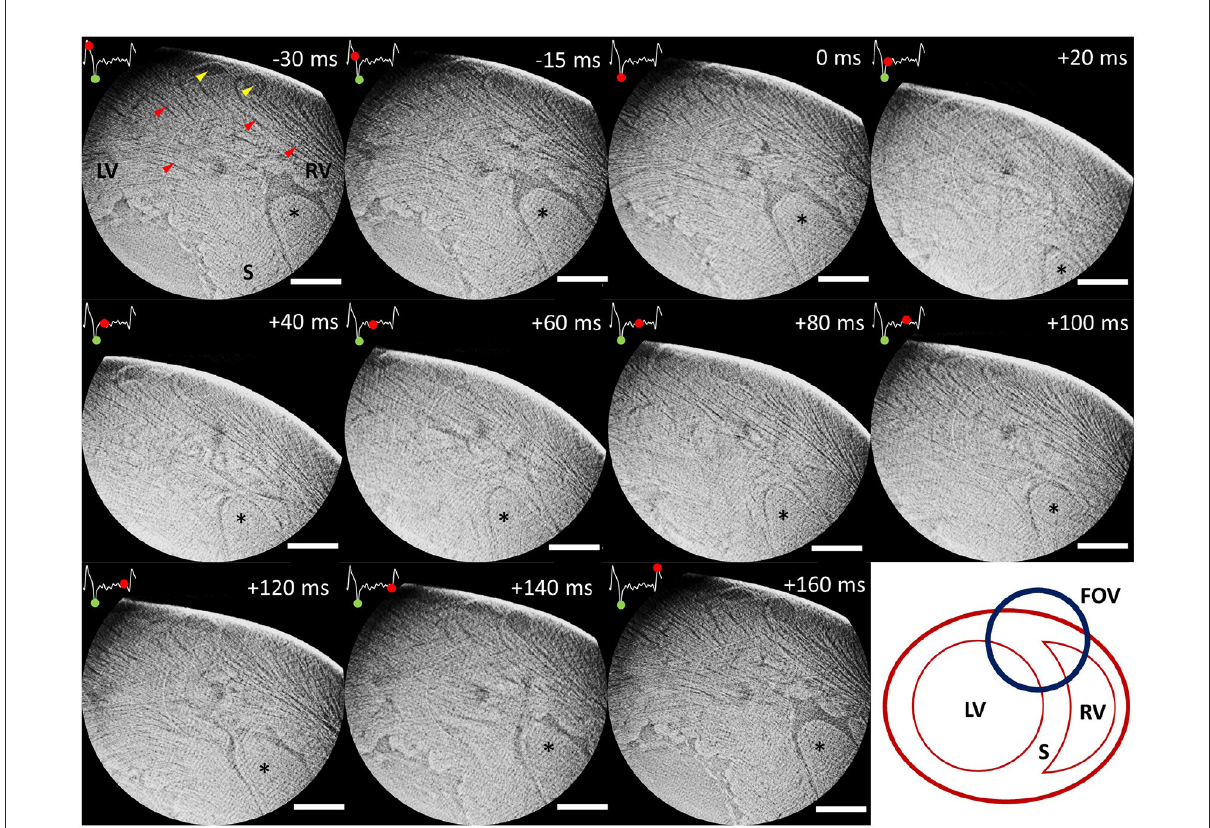
FIGURE3 Time-series of an illustrative slice showing the region where left ventricular wall (LV), septum (S) and right ventricular wall (RV) join. Time is indicated using the start of the contraction as reference (0 ms). An ECG signal corresponding to a full heartbeat is included in every slice. The green dot on the ECG indicates the start of the contraction (reference time-point), while the advancing red dot corresponds to the exact reconstruction location. A right ventricular trabeculation has been marked (*) to clearly follow myocardial contraction and relaxation over time. Yellow arrows point at coronary vasculature, while red arrows point at cardiomyocyte aggregates. The bottom right image shows a sketch of the presented heart region. Scale bar is 1